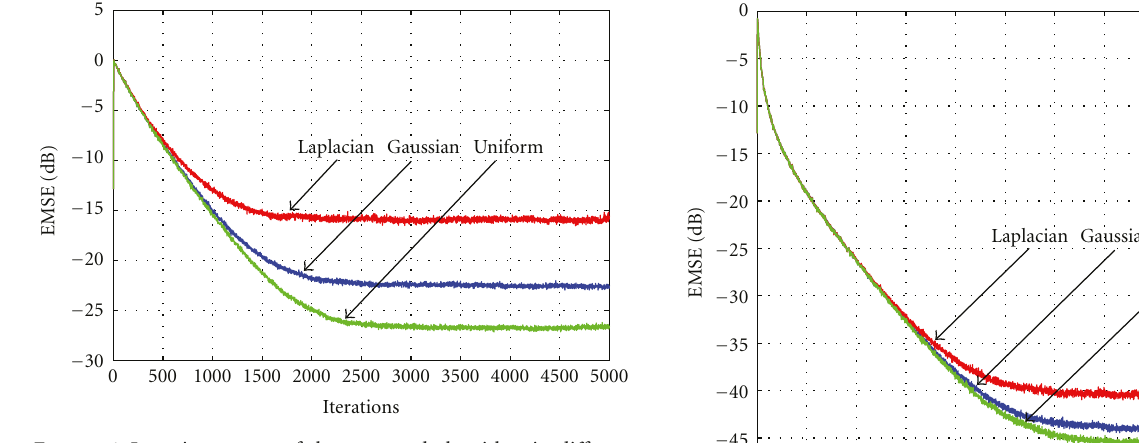
Figure 6: Learning curves of the proposed algorithm in di ff erent noise environments scenarios for α = 0 . 8 and SNR of 0dB.